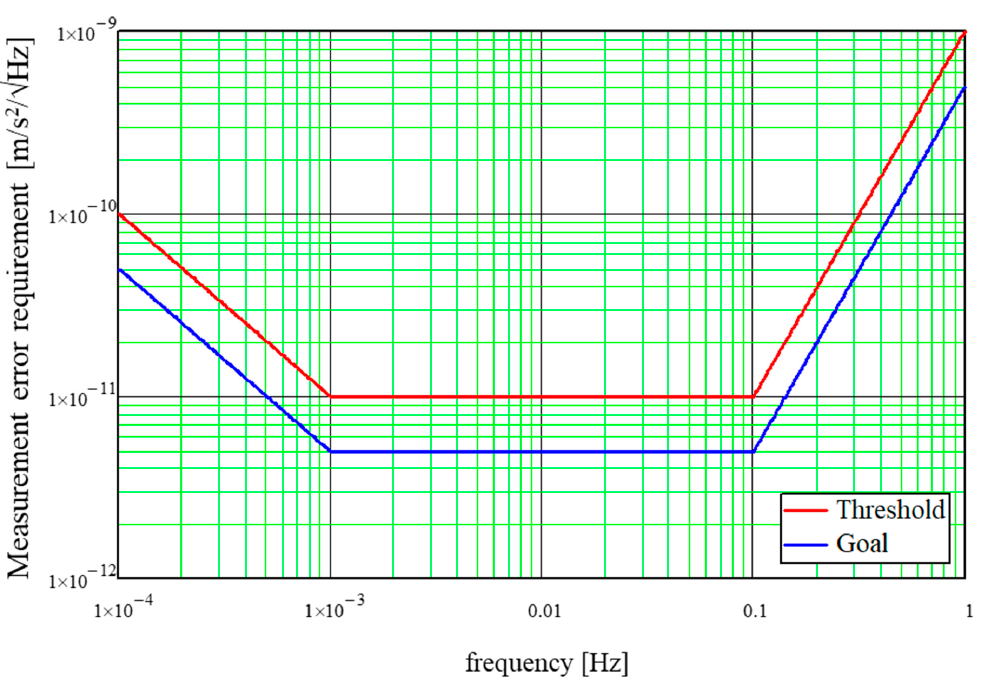
Figure 4. Requirements (threshold and goal) on the stochastic measurement error of Δ a D .